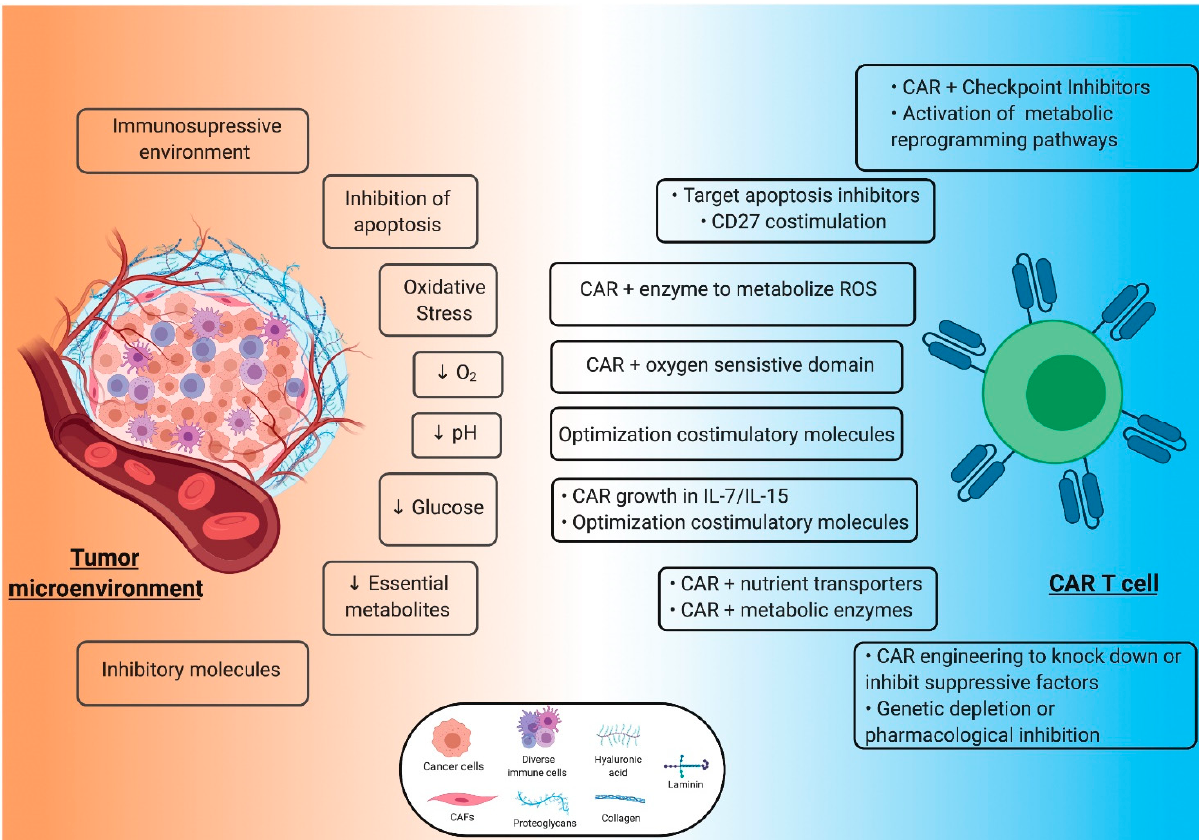
Figure 2. Tumor microenvironment and chimeric antigen receptor (CAR) T-cell immunotherapy strategies. The figure shows the different strategies developed to improve CAR T-cells metabolic fitness and anti-tumor activity in response to the hostile immunosuppressive effect of the tumor metabolism. CAFs, cancer associated fibroblasts. Created with Biorender.